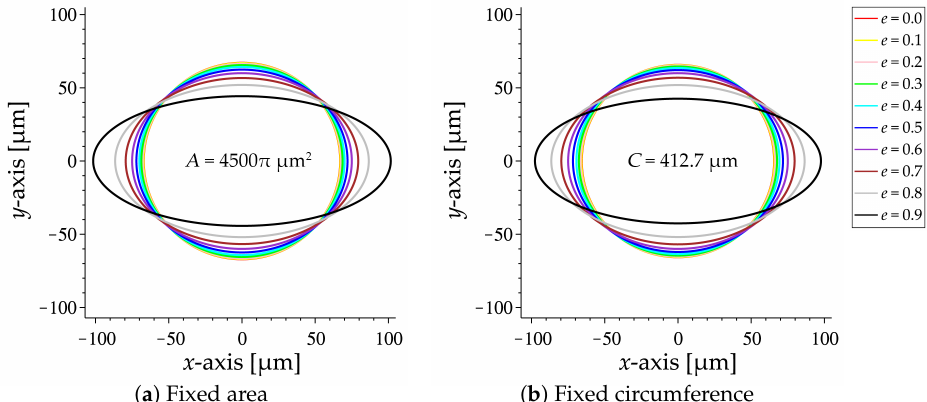
Figure 4. Variation of the elliptic cross-sections of the channel on various eccentricities with: ( a ) Fixed area of the channel cross-sections; ( b ) Fixed circumference of the channel cross-sections.